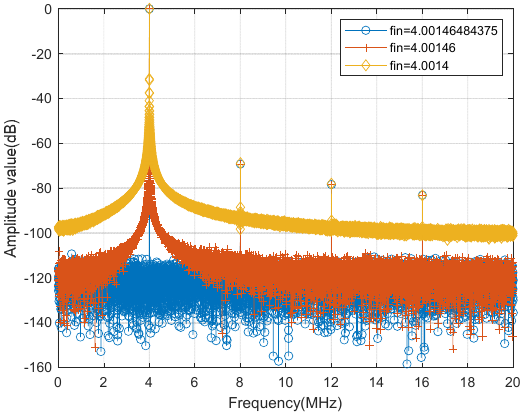
Figure 2. Spectrum comparison of coherent and incoherent sampling.